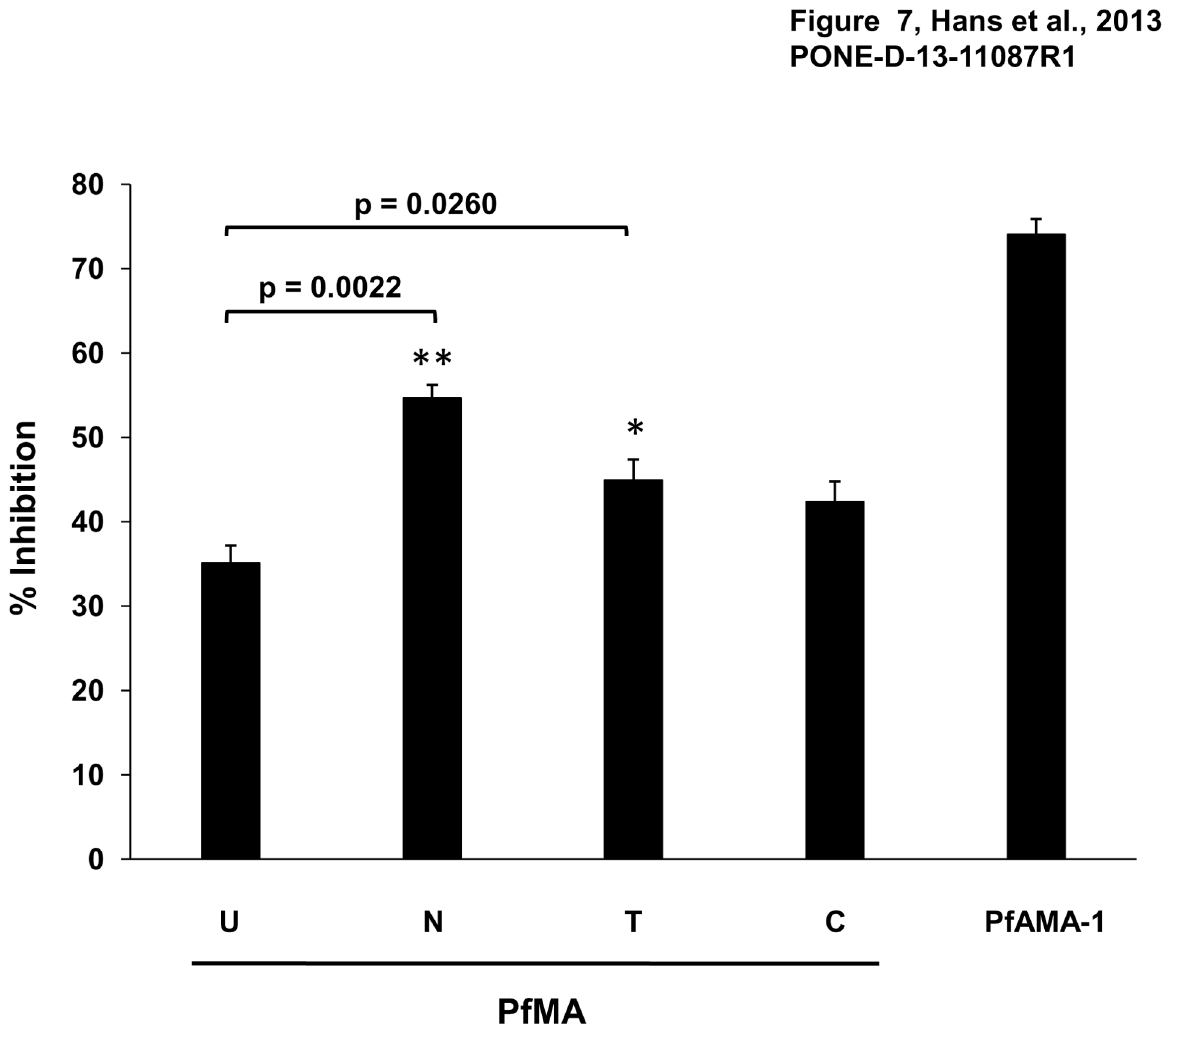
Figure 7. Invasion inhibitory activity of PfMA antibodies. PfMA antibodies were evaluated for their invasion inhibition activity against the P. falciparum 3D7 clone. Purified rabbit IgG at a concentration of 20 mg/ml was tested with different enzyme treated erythrocytes. The antibodies exhibited 35% inhibition of untreated erythrocytes (U), 54.6% inhibition of neuraminidase treated erythrocytes (N), 44.95% inhibition of trypsin (T) treated erythrocytes and 42.3% inhibition of chymotrypsin (C) treated erythrocytes. The control PfAMA-1 antibodies at 5mg/ml exhibited 71% inhibition. Three independent experiments were done in duplicate. The error bars represent the standard error of the mean between the assays. Statistical significance between invasion inhibition of untreated and enzyme-treated erythrocytes was calculated by the Student’s t-test with a p value < 0.05 indicating statistical significance (*p < 0.05; ** p <